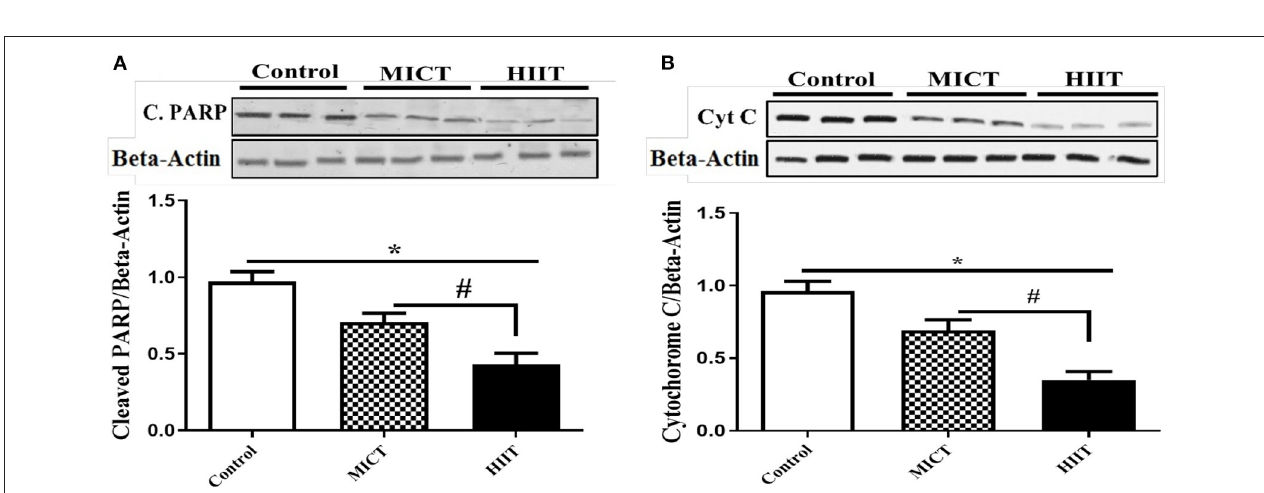
FIGURE 2 | Effects of exercise on miR-206 mRNA. (A) HSP60 protein expression. (B) Data are presented as means ± standard error of the mean (SEMs). *Significant differences between control and intervention groups, # Significant differences between MICT and HIIT. MICT, moderate-intensity continuous training; HIIT, high-intensity interval training; n = 6 and rats trained for 5 weeks.